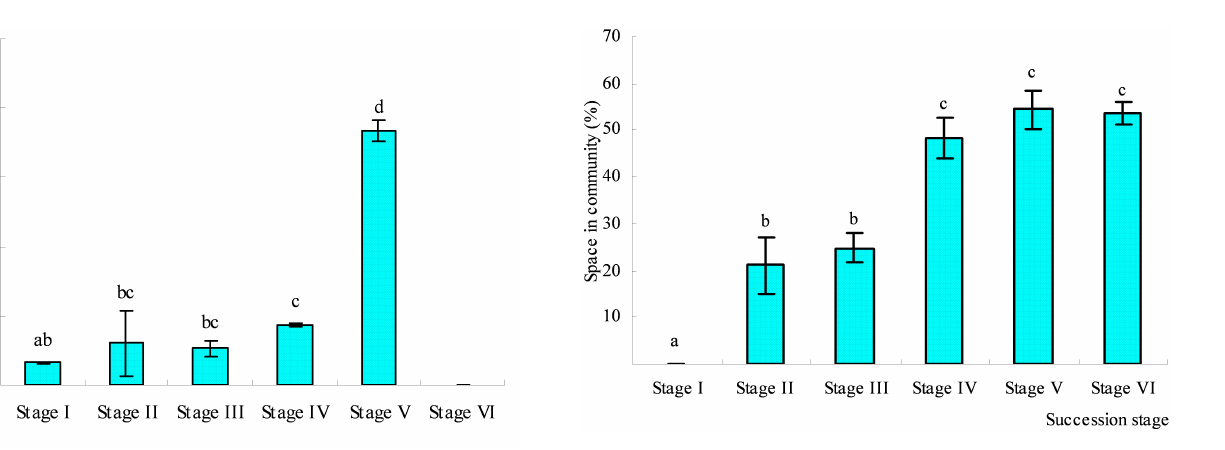
Figure 7. The space coverage over the course of succession. The values represent the means ± 1SD of four replicates. Different let- ters in the figures indicate significant differences between stages at P <0.05. The stage details refer to Fig.